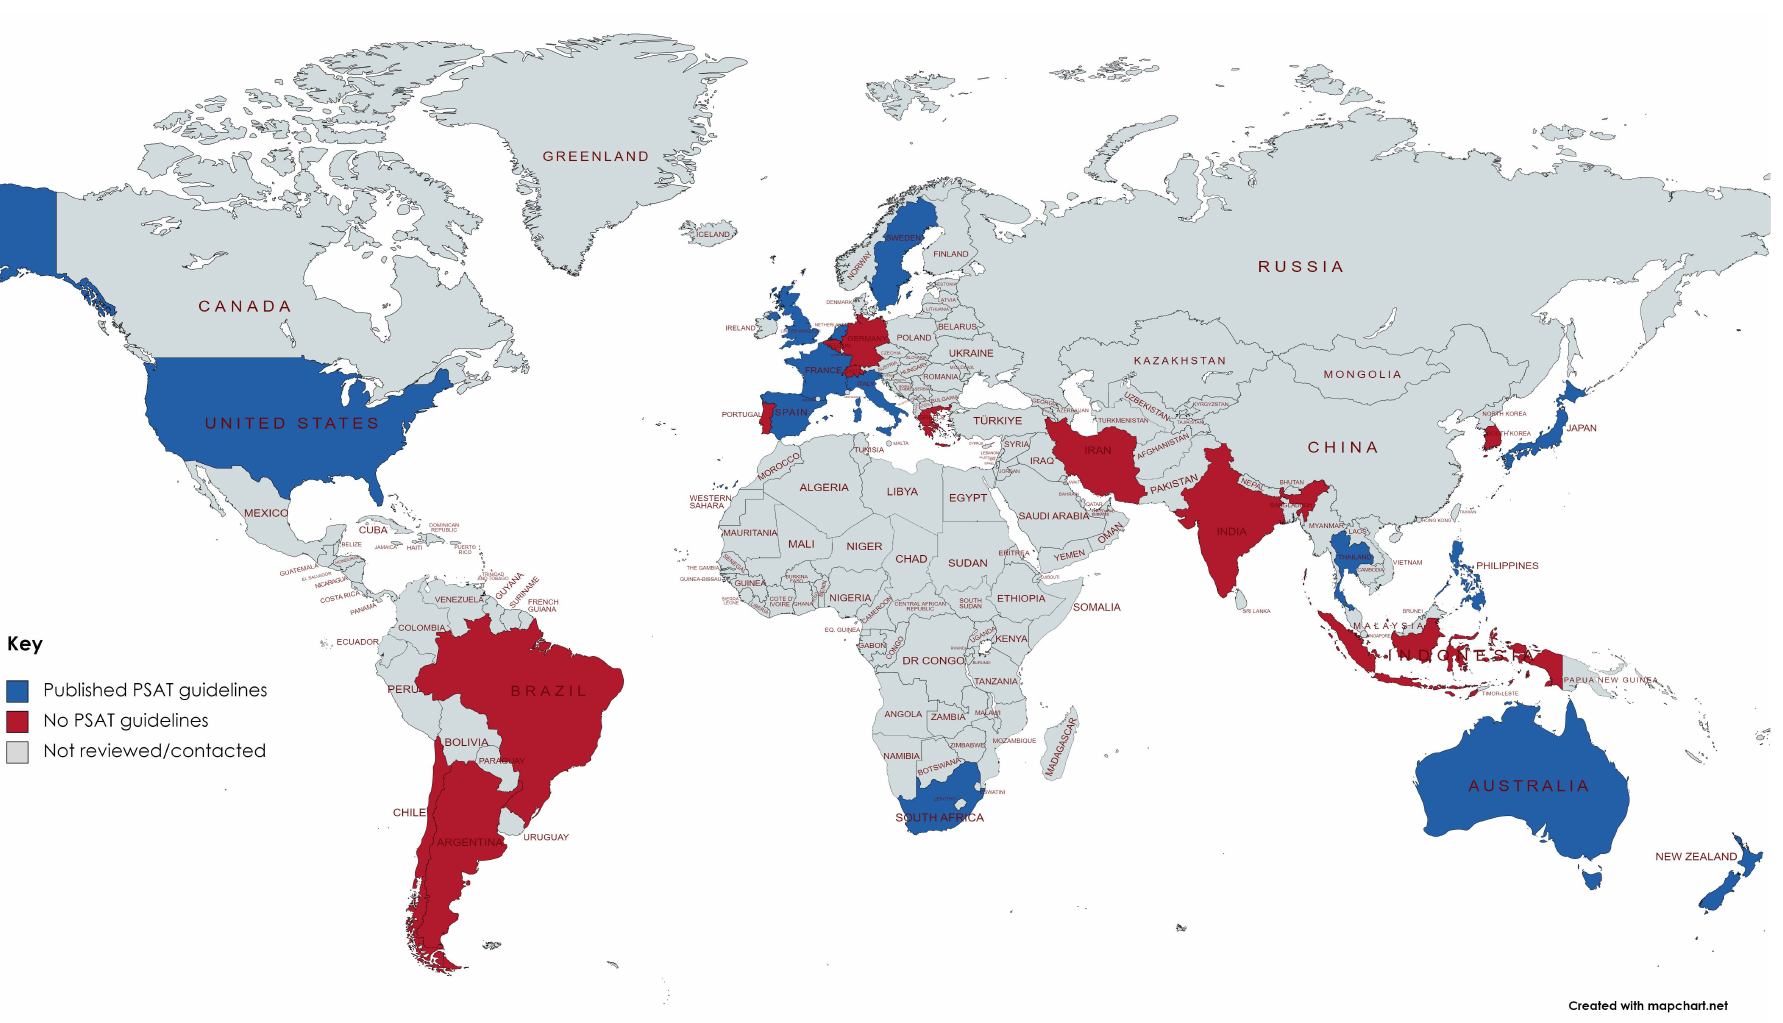
Figure 1. Map of countries reviewed for PSAT guidelines. Blue—published PSAT guidelines; Red—no PSAT guidelines; Grey—not reviewed or contacted. (Created using